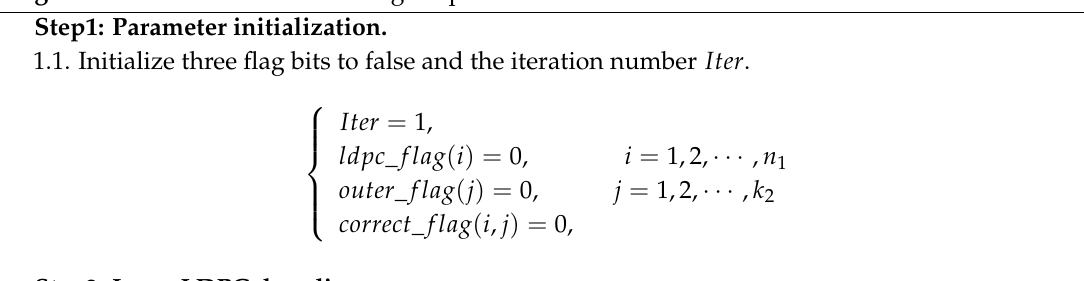
Algorithm 1: The iterative decoding for product